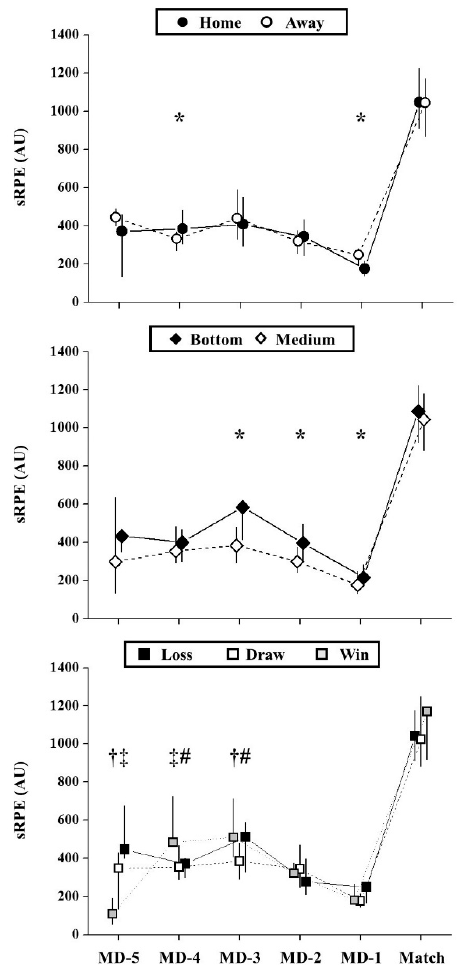
Figure 2. E ff ects of contextual factors on weekly internal load parameter (sRPE). *: Significant di ff erences between home vs. away or bottom- vs. medium-ranking opponents ( p < 0.05). #: Significant di ff erences between days before win vs. draw matches ( p < 0.017); ‡ : Significant di ff erences between days before win vs. loss ( p < 0.017); MD-5 = five days before the match; MD-4 = four days before the match; MD-3 = three days before the match; MD-2 = two days before the match; MD-1 = one day before the match. † : Signi fi cant di ff erences between days before loss vs. draw ( p < 0.017).